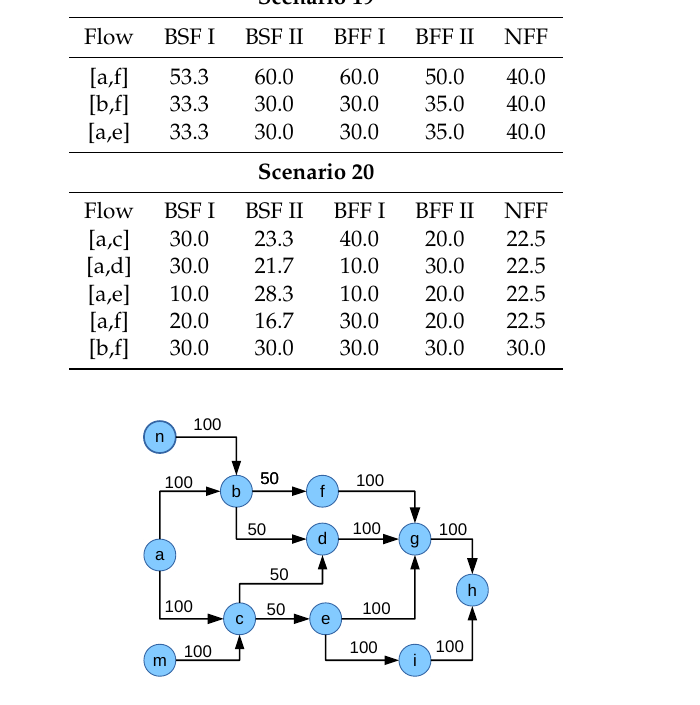
Figure 20. Scenario 8—Meshed network. The numbers specify the link speeds in